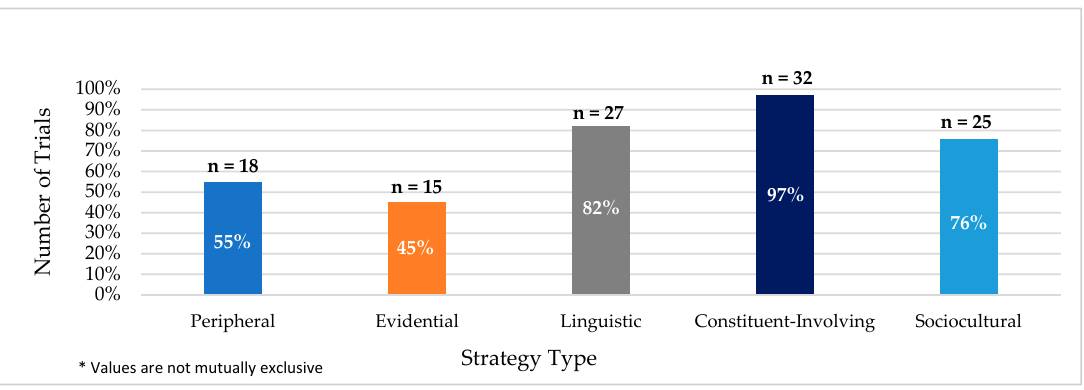
Figure 1. Use of cultural tailoring strategies among trials.